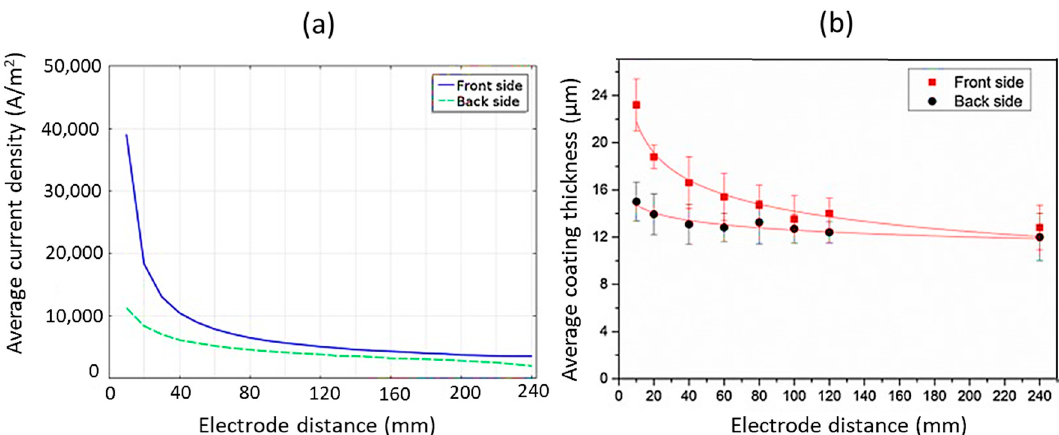
Figure 19. Graphs depicting ( a ) average current density on the front and back sides of the substrate versus electrode distance, and ( b ) average coating thickness produced against electrode distances of 10, 20, 40, 60, 80, 100, 120, and 240 mm for both front and back sides. Reproduced with permission from [151]. Copyright Elsevier, 2016.